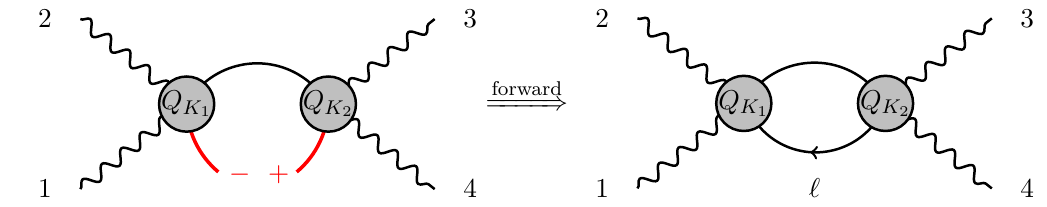
Figure 3 . The bubble diagram comes from gluing the leg-( n +1) and leg-( n +2) (denoted by (cid:0) and +, respectively) of a six-point tree amplitude. The original s 12 n +1 channel becomes the linear propagator of the (cid:12)rst term in (4.9).